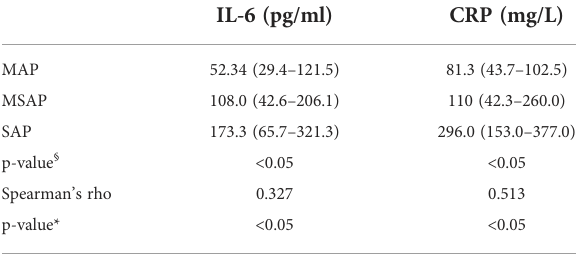
TABLE 3 Serum interleukin-6 (IL-6) and C-reactive protein (CRP) levels in patients with acute pancreatitis and their correlation with